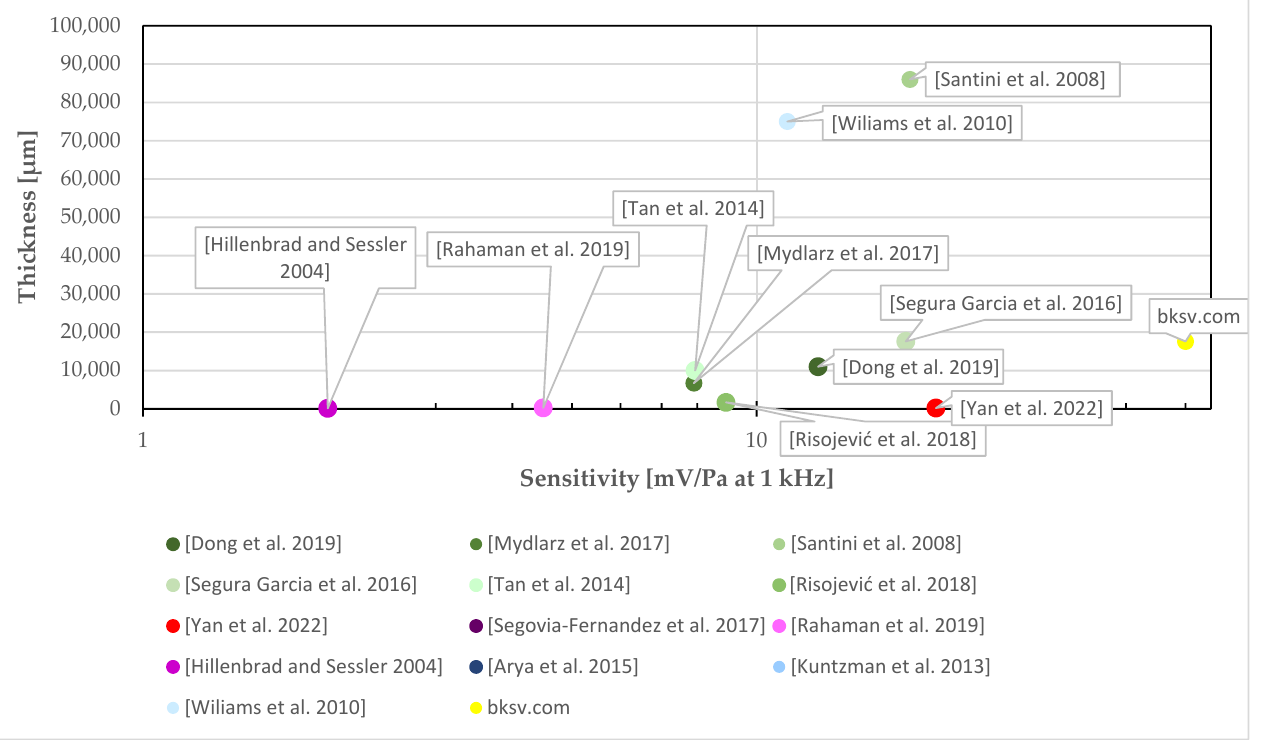
Figure 3. Relationship between the thickness and sensitivity of the literature. The sensors of current monitoring systems are in the gradient of green ([Dong et al. 2019] [15], [Mydlarz et al. 2017] [16], [Santini et al. 2008] [18], [Segura Garcia et al. 2016] [19], [Tan et al. 2014] [20], [Risojevi´c et al. 2018] [21]). The PAS yarn is red ([Yan et al. 2022] [30]). The PAS film in D33 mode is the gradient of violet ([Segovia-Fernandez et al. 2017] [47], [Hillenbrad and Sessler 2004] [48], [Rahaman et al. 2019] [49]. The MEMs are in gradient of blue [57], [Arya et al. 2015] [58], [Kuntzman et al. 2013] [59], [Wiliams et al. 2010] [60]) and reference microphone is yellow ([bksv.com]